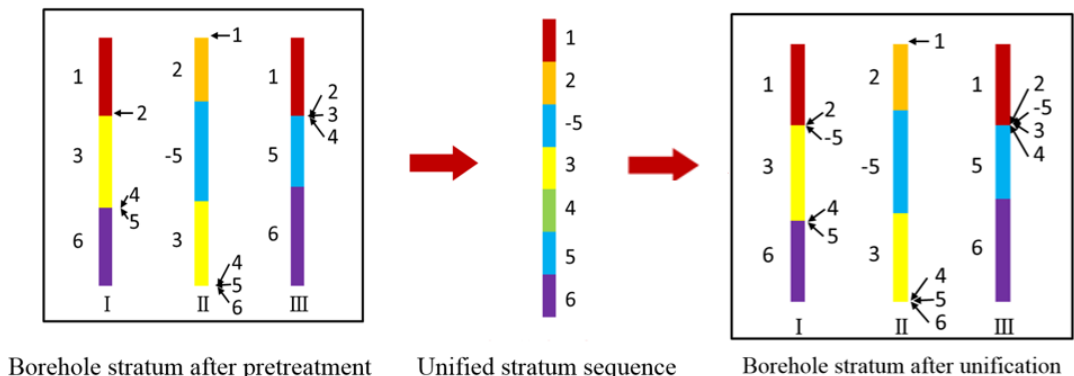
Figure 2. Schematic diagram of unified stratigraphic sequence method. A two-dimensional (nonmatrix) array of the same lithology is obtained from the layer sequences of all boreholes. Each row contains different repeated layer numbers and records the different positions of all the layer numbers in the unified stratigraphic sequence. The layer elevation information (including the top and bottom boundary elevations) of all boreholes is unified into a two-dimensional layer elevation matrix, and each row corresponds to the unified stratigraphic sequence with an extra group. Local and global two-dimensional boundary marker matrix with a default value of 1 is created corresponding to the layer depth matrix and is used to control whether the layer boundaries between two adjacent boreholes are drawn. As shown in Figure 3, the stratum represented by the yellow background should not exist between the two boreholes on the right of Figure 3a as explicit boundaries, which means the same lithological strata above and below the yellow formation converge to form a single stratum, and thus, the yellow stratum would be drawn to pinch-out between the two boreholes on the left side. The explicit boundaries between the two boreholes on the right disappear and become the implicit boundaries that won’t be drawn. The explicit and implicit of upper and lower adjacent strata boundary can be identified by program automatically, and that means the pinch-outs can be identified as the